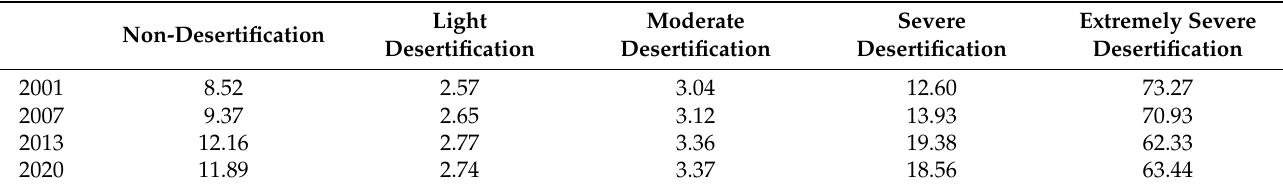
Table 4. Proportion of the desertification degree area in Xinjiang in different years